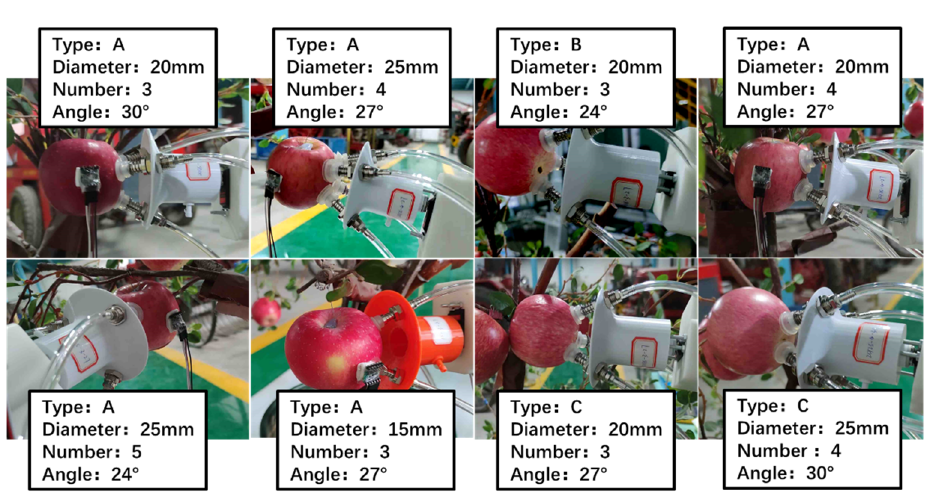
Figure 32. Part of the test process pictures.